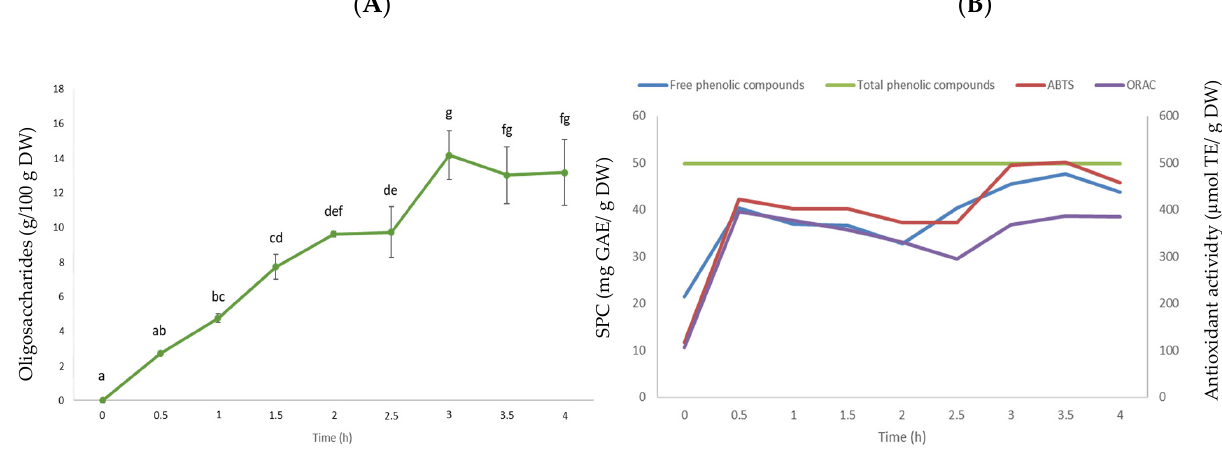
Figure 2. Time course of the extraction of oligosaccharides ( A ) and phenolic compounds and the increase in antioxidant activity as determined by ORAC and ABTS assays ( B ). Data are the mean ± standard deviation (n = 6). Different lowercase letters indicate statistical differences among each time ( p ≤ 0.05 Bonferroni’s post hoc test). Green line in panel ( B ) represents the total phenolic content in untreated lentil hulls. Abbreviations: ABTS, 2,2 ′ -azino-bis-3-ethylbenzothiazoline-6-sulfonic acid radical scavenging activity; ORAC, oxygen radical absorbance capacity; SPC, soluble phenolic compounds; GAE, gallic acid equivalents; TE, Trolox equivalents; DW, dry